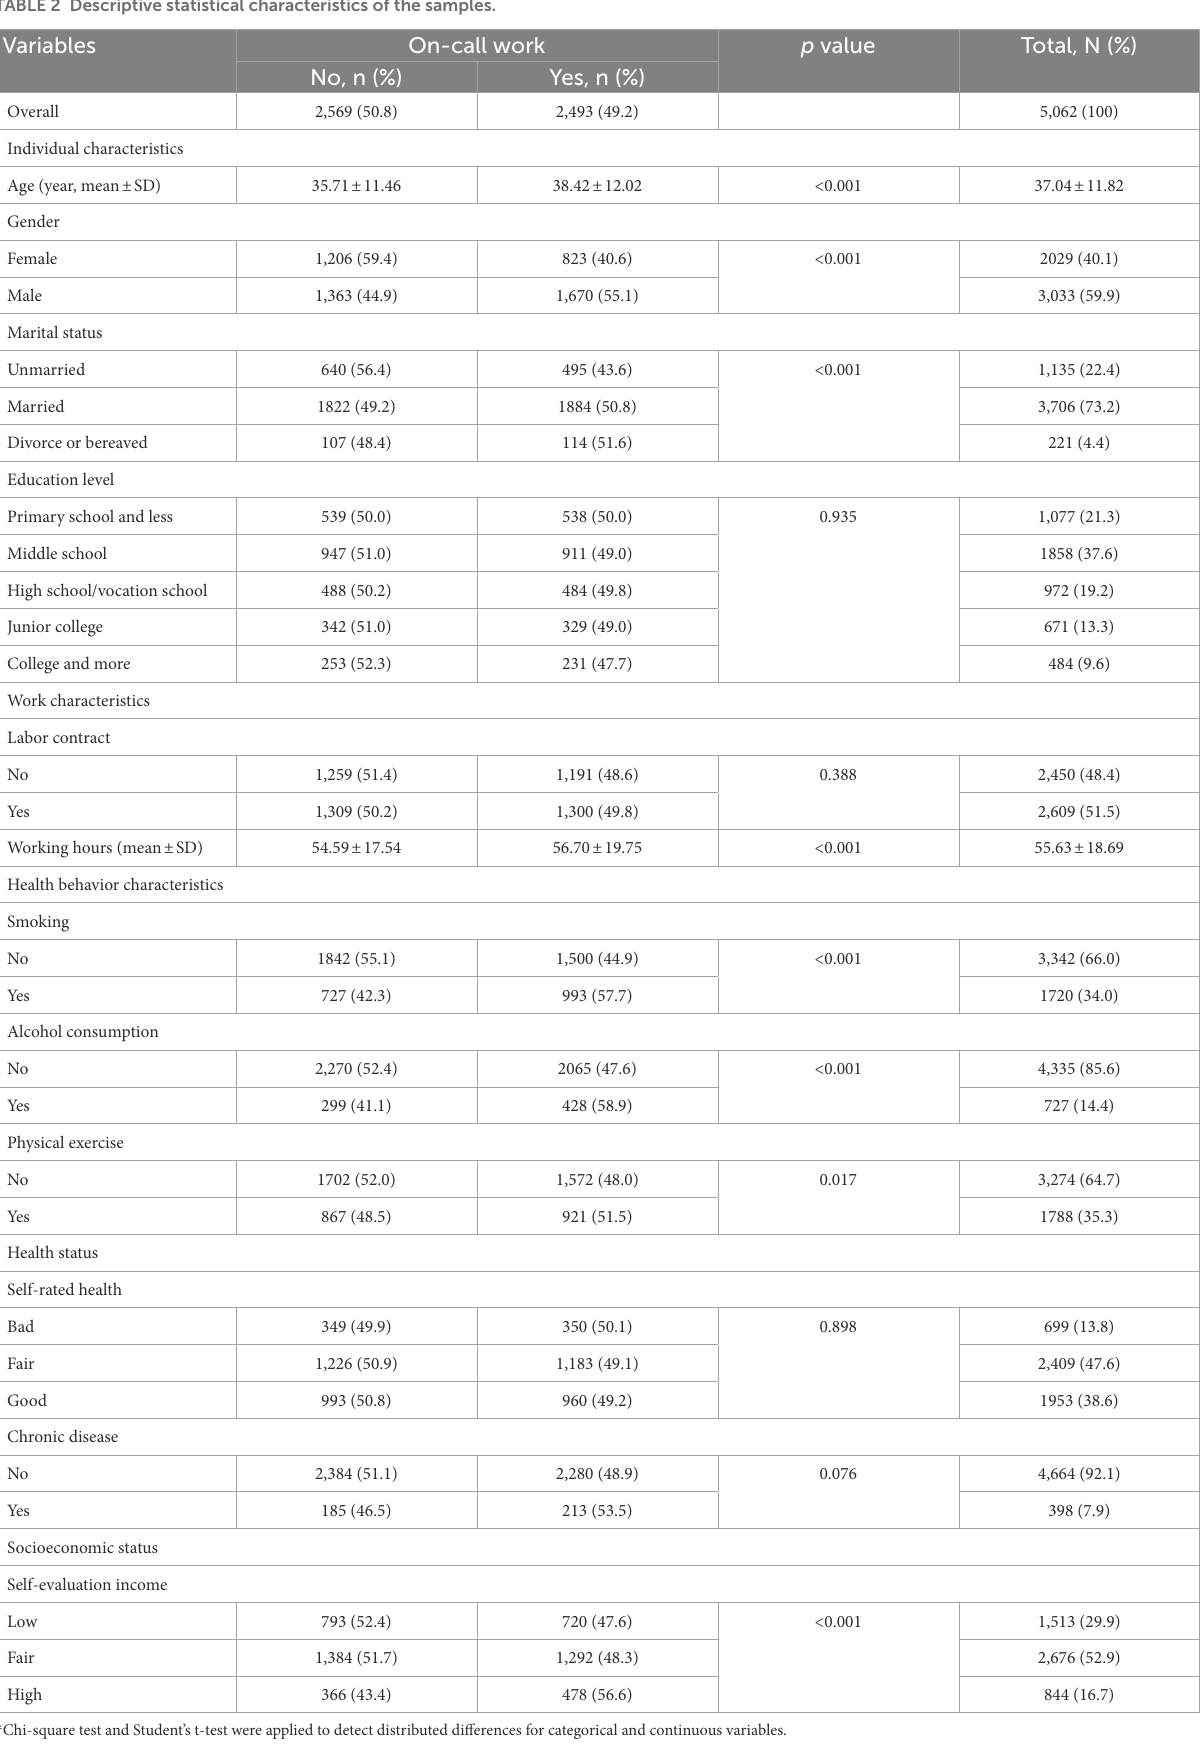
TABLE 2 Descriptive statistical characteristics of the